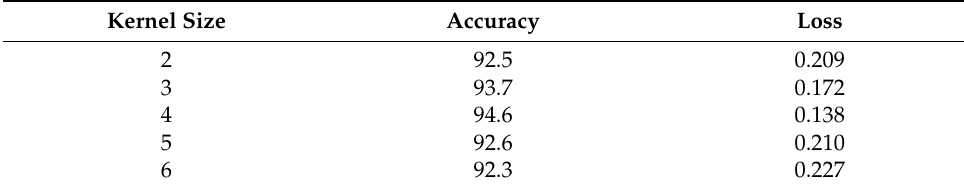
Table 4. Comparison of different kernel sizes in the Attention-TCN-BiGRU. Kernel Size